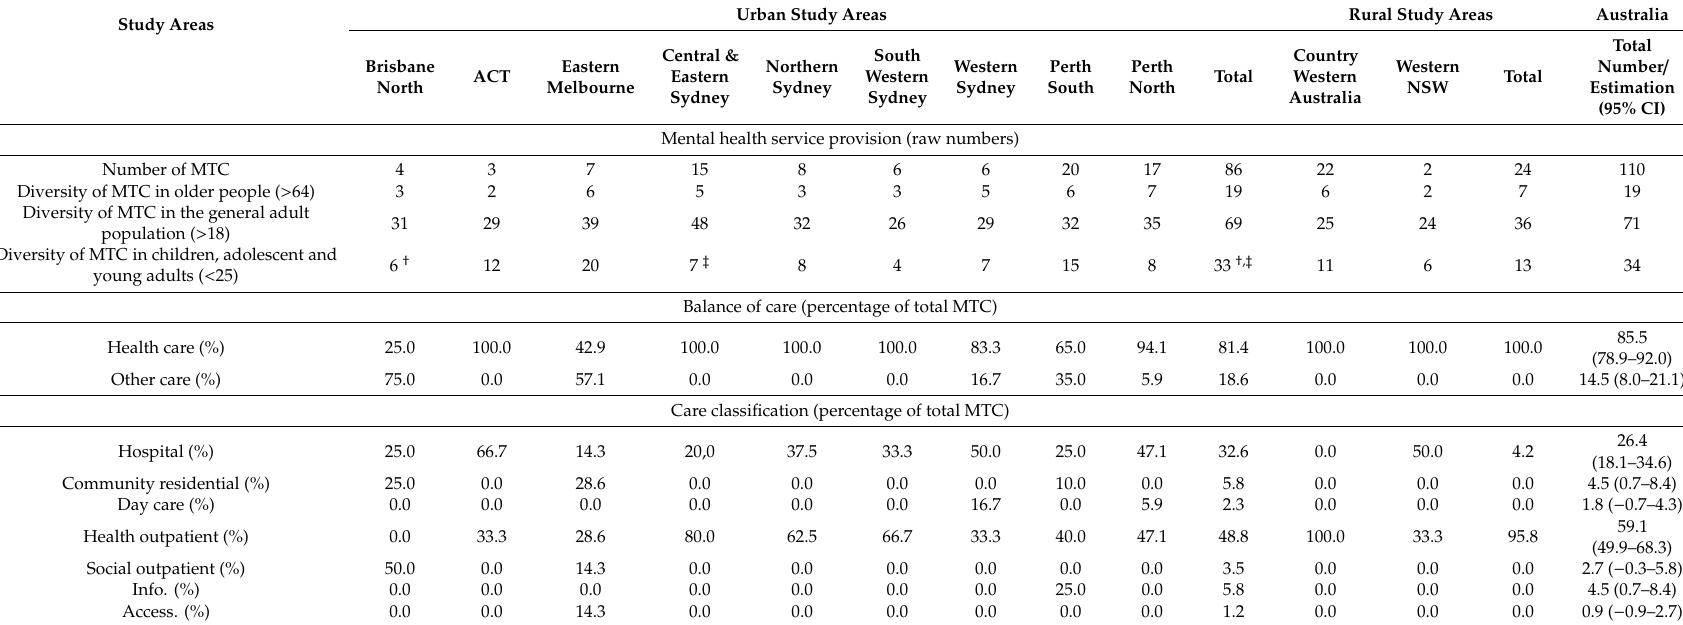
Table 2. Diversity, pattern and balance of older people’s mental health main types of care in the study areas. Study